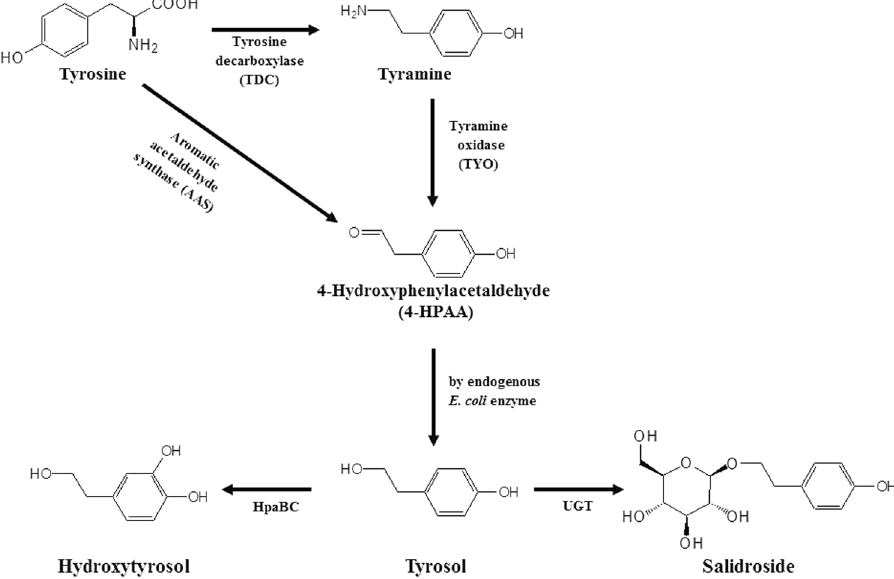
Figure 1. Scheme of biosynthesis of three phenylethanoids, tyrosol, hydroxytyrosol, and